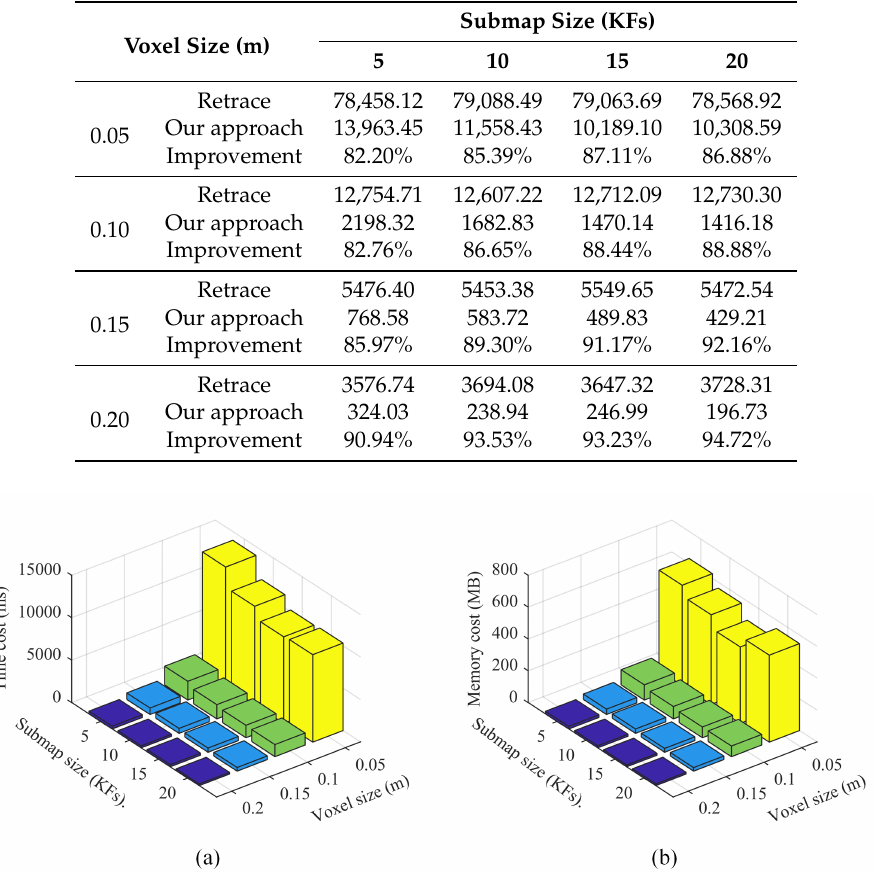
Figure 14. ( a ) time cost and ( b ) memory cost of our approach with various voxel sizes and submap